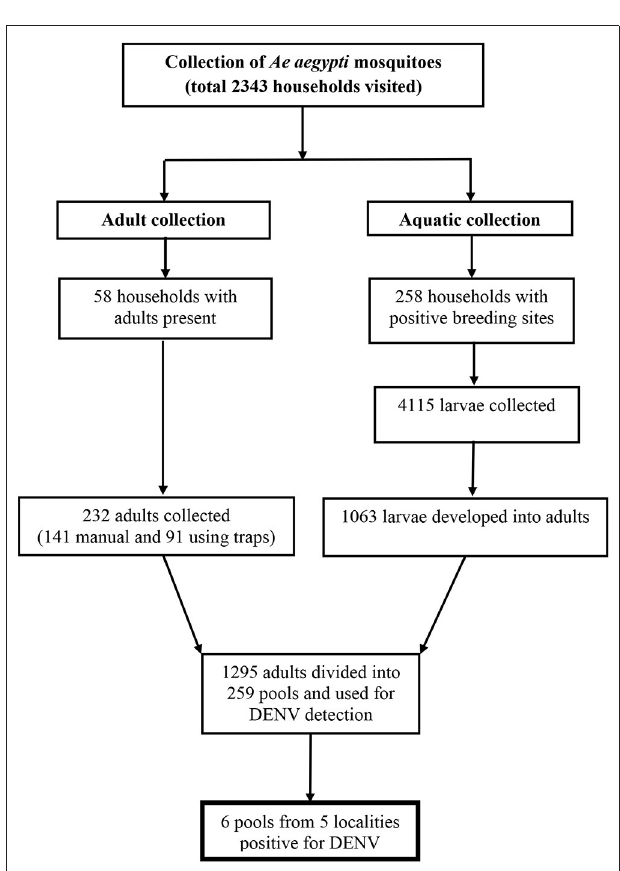
FIGURE 1 | Flowchart for Ae aegypti